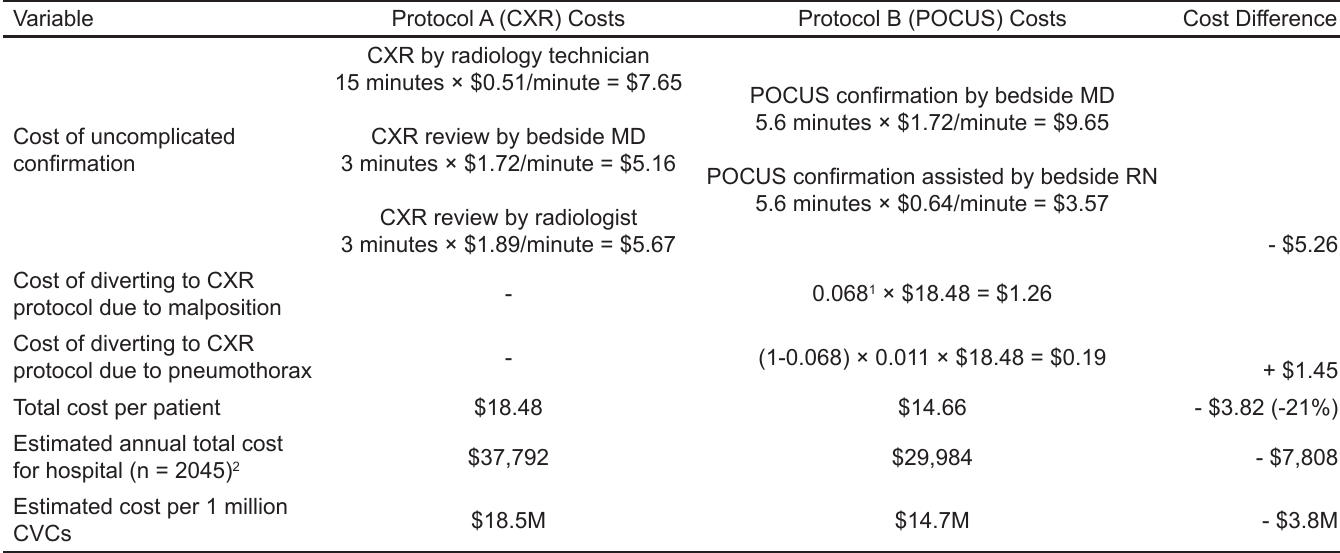
Table 3. Cost comparison between Protocol A versus B.